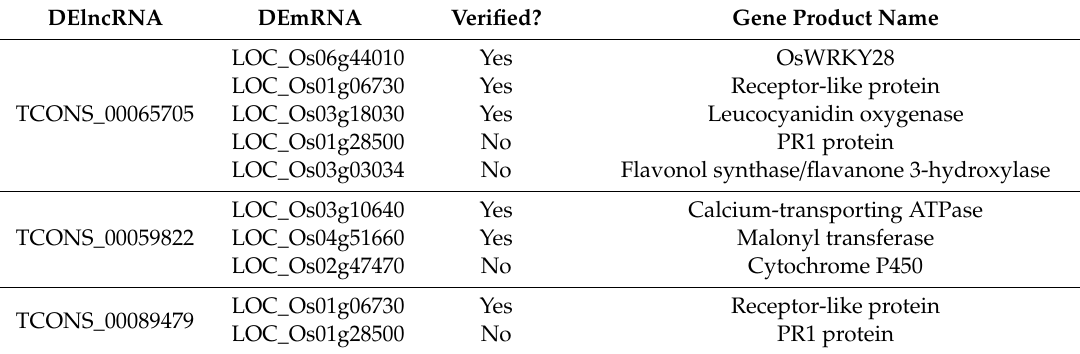
Table 4. List of tested DElncRNAs and